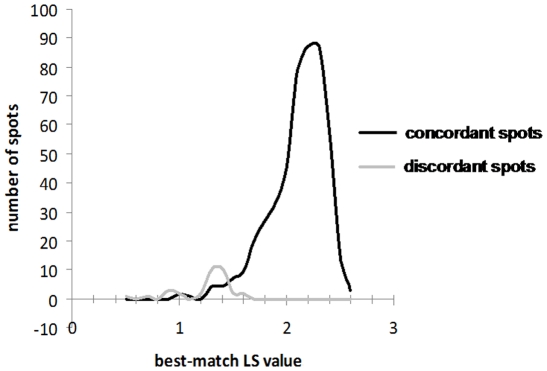
Distribution of the best-match LS values issued from the identification of the clinical isolates.This figure shows the distribution of the best-match LS values for each of the 4 spots issued from identification of the 156 clinical isolates. The dark line indicates the best-match LS values of the concordant spots whereas the gray line shows the best-match LS values of the discordant ones. Concordant and discordant spots best-match LS value distributions were almost distinct.